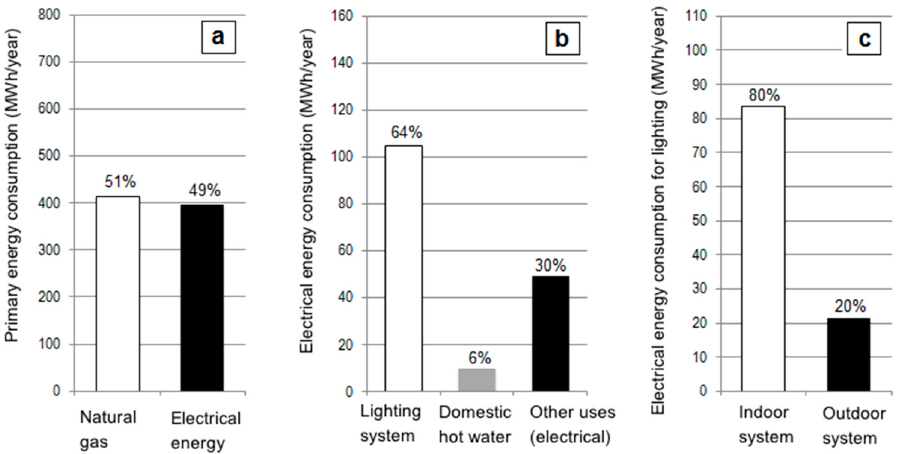
Figure 6. Distribution of the calculated consumptions: ( a ) Primary energy; ( b ) Electrical energy; and ( c ) Electrical energy used for lighting.